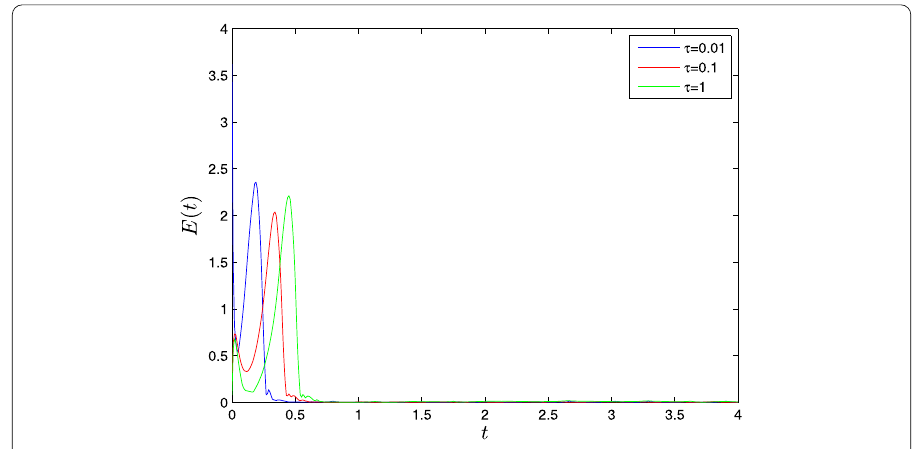
Figure 1 Time evolution of the lag synchronization error E ( t ).